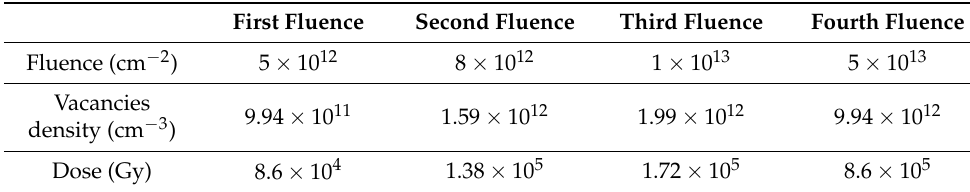
Figure 4. Dark I–V characterization. The curve before any test (irradiation and IBIC) is represented in black, while the curve after all irradiations (both at room temperature and at high temperature) is represented in red. Table 1. Fluences used to irradiate the sensor at both room and high temperatures, with a 3.5 MeV proton beam (transmission beam). Four fluences were chosen at both room temperature and high temperature. Respective vacancies’ densities and the doses are also